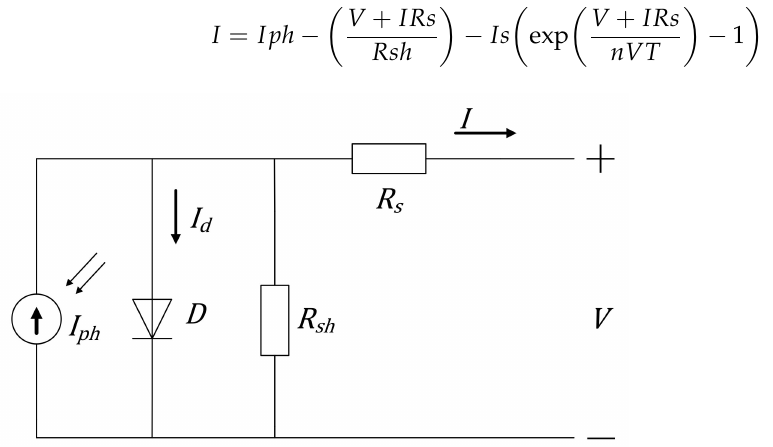
Figure 1. Single diode equivalent circuit model of solar